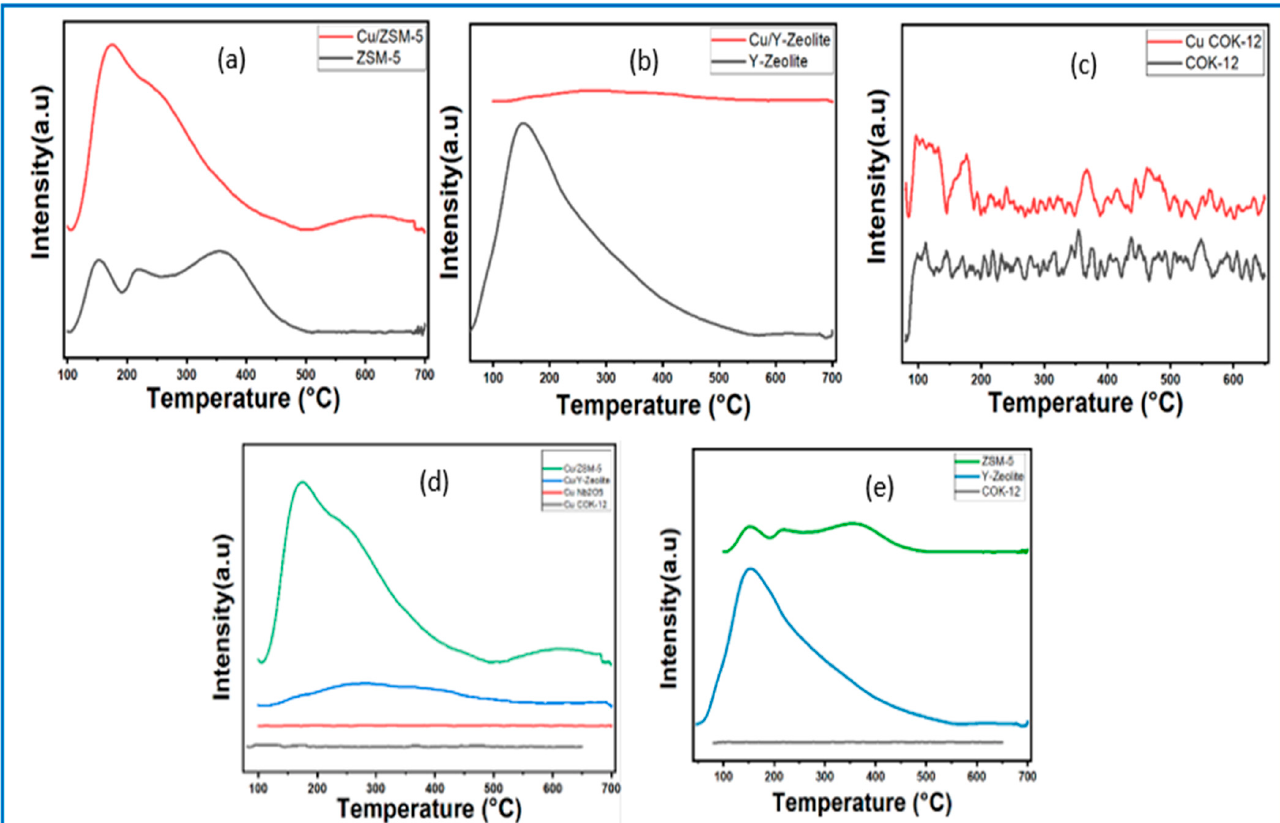
Figure 9. CO2-TPD profiles of ( a ) Cu-ZSM5 and ZSM5, ( b ) Cu-Y-Zeolite and Y-Zeolite, ( c ) Cu/COK12 and COK12, ( d ) Cu modified COK12, Nb2O5, Y-Zeolite, and ZSM5 catalysts, and ( e ) and COK12, ( d ) Cu modified COK12, Nb 2 O 5 , Y-Zeolite, and ZSM5 catalysts, and ( e ) ZSM5, ZSM5, Y-Zeolite, and COK12 support.